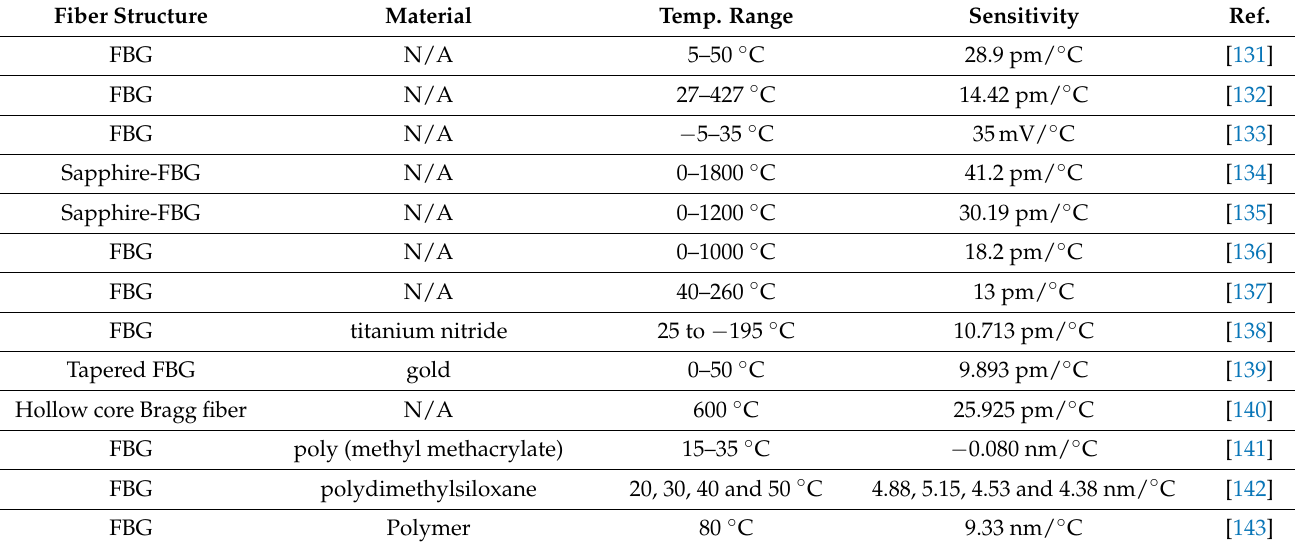
Table 3. Summary of FBG-based temperature